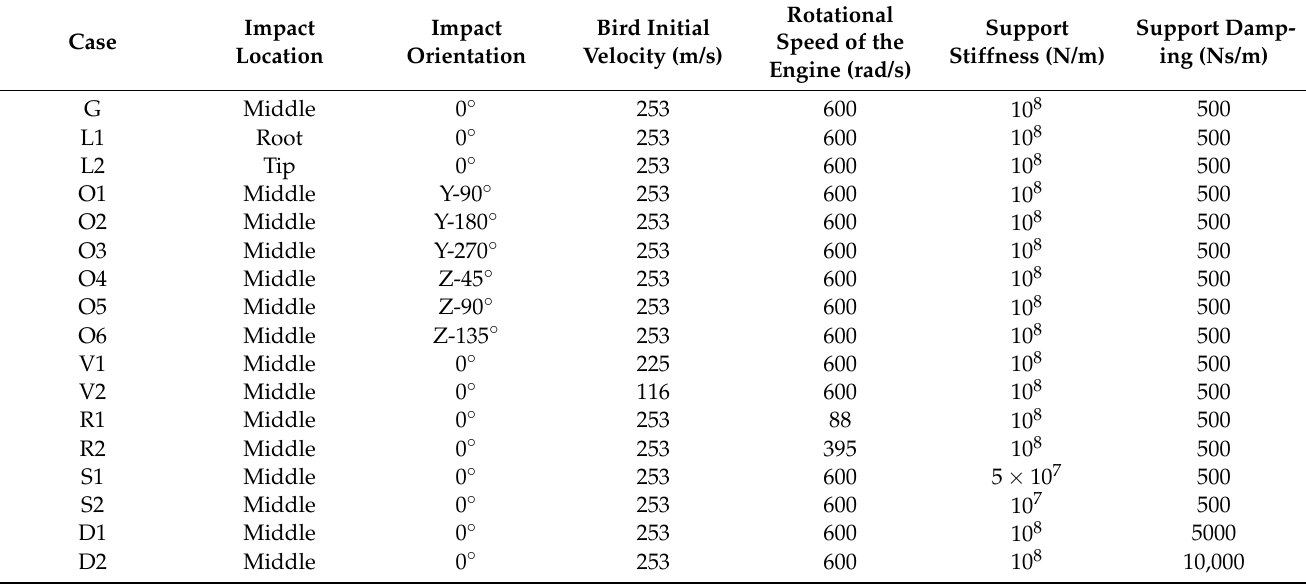
Table 5. Different case studies considered for studying different parameters in the bird strike